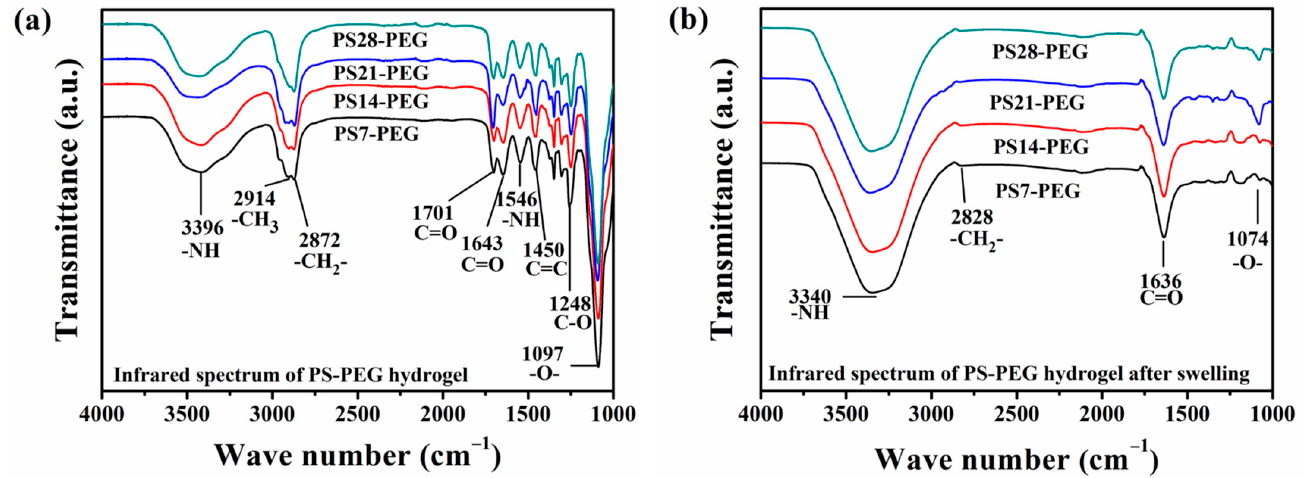
Figure 6. Infrared spectra of the hydrogels: ( a ) XH; ( b ) SSH.